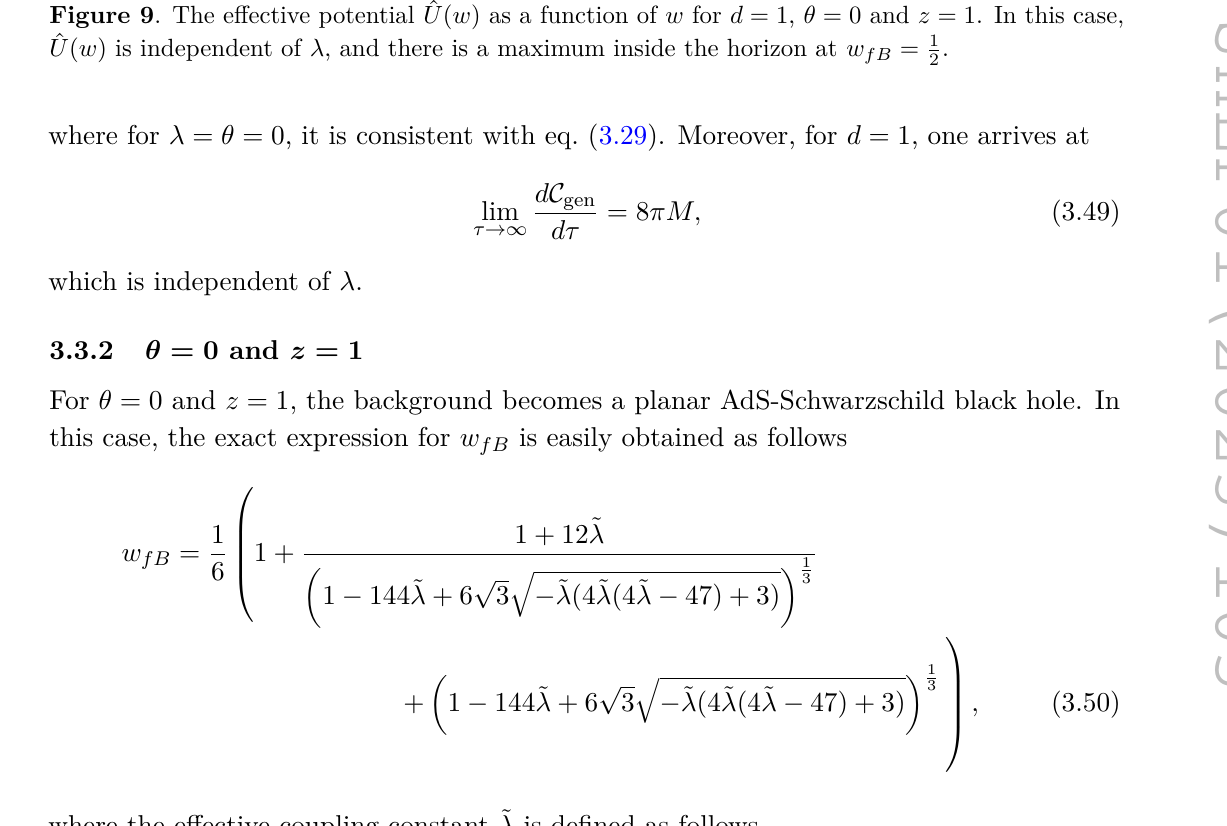
ˆ U ( w ) as a function of w for d = 1 , θ = 0 and z = 1 . In this case,